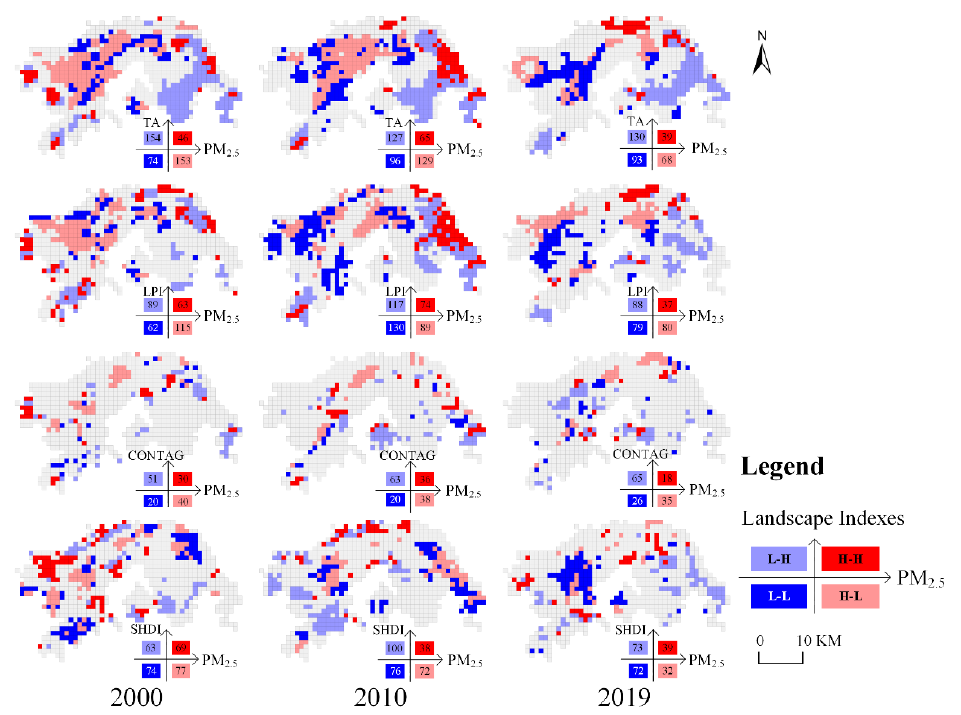
Figure 4. Local spatial correlations of PM 2.5 and landscape patterns in the last two decades. (As mentioned in the methodology, “H-H” represents the high value of landscape indexes and PM 2.5 concentration clusters in the spatial scale. The number inside of the rectangle is the calculation of grids, and for example, the number of “H-H” of SHDI and PM 2.5 in 2000 is 69).